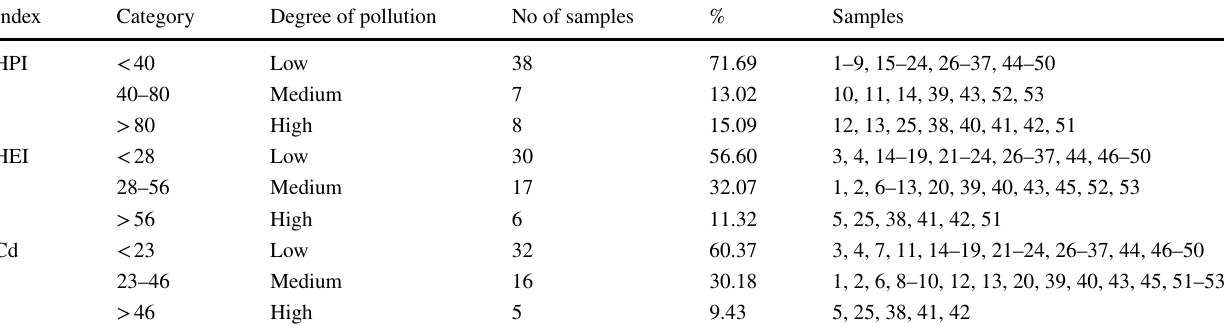
Table 2 Classification of groundwater quality of the region based on categories of pollution indices